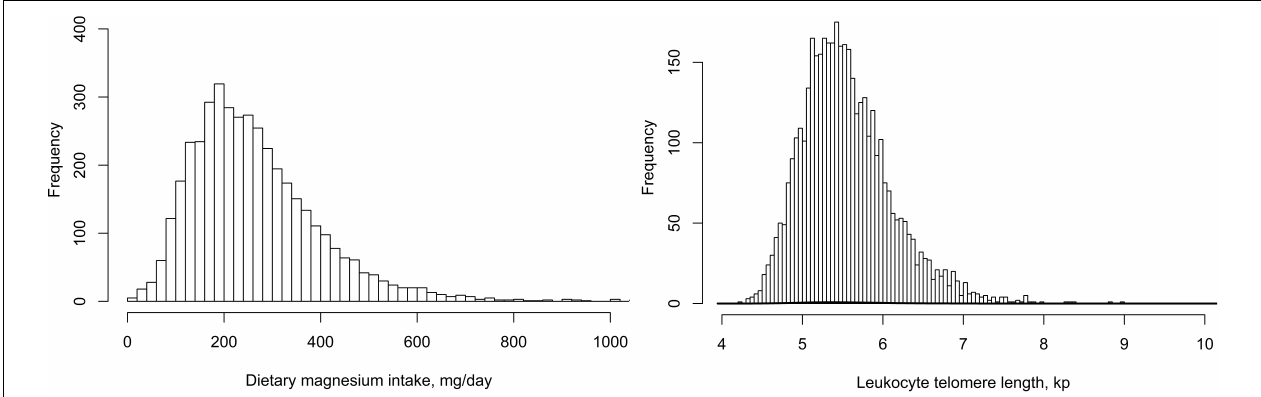
FIGURE 2 | The distributions of dietary magnesium intake and leukocyte telomere